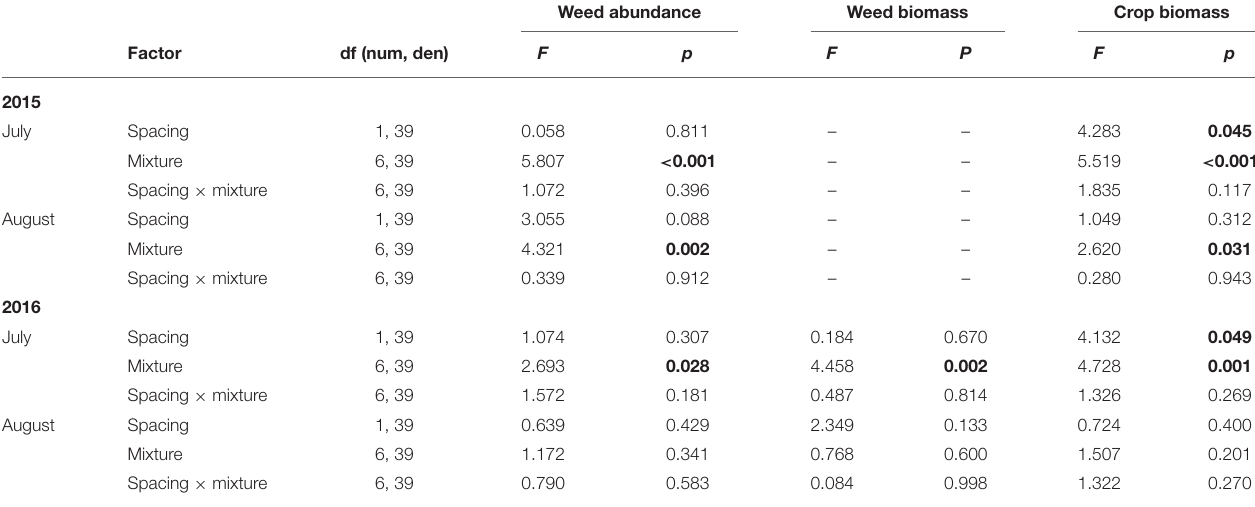
TABLE 2 | Mixed model results of weed abundance (2015, 2016), weed biomass (2106), and crop biomass (2015, 2016) with crop spacing and crop mixture from the field